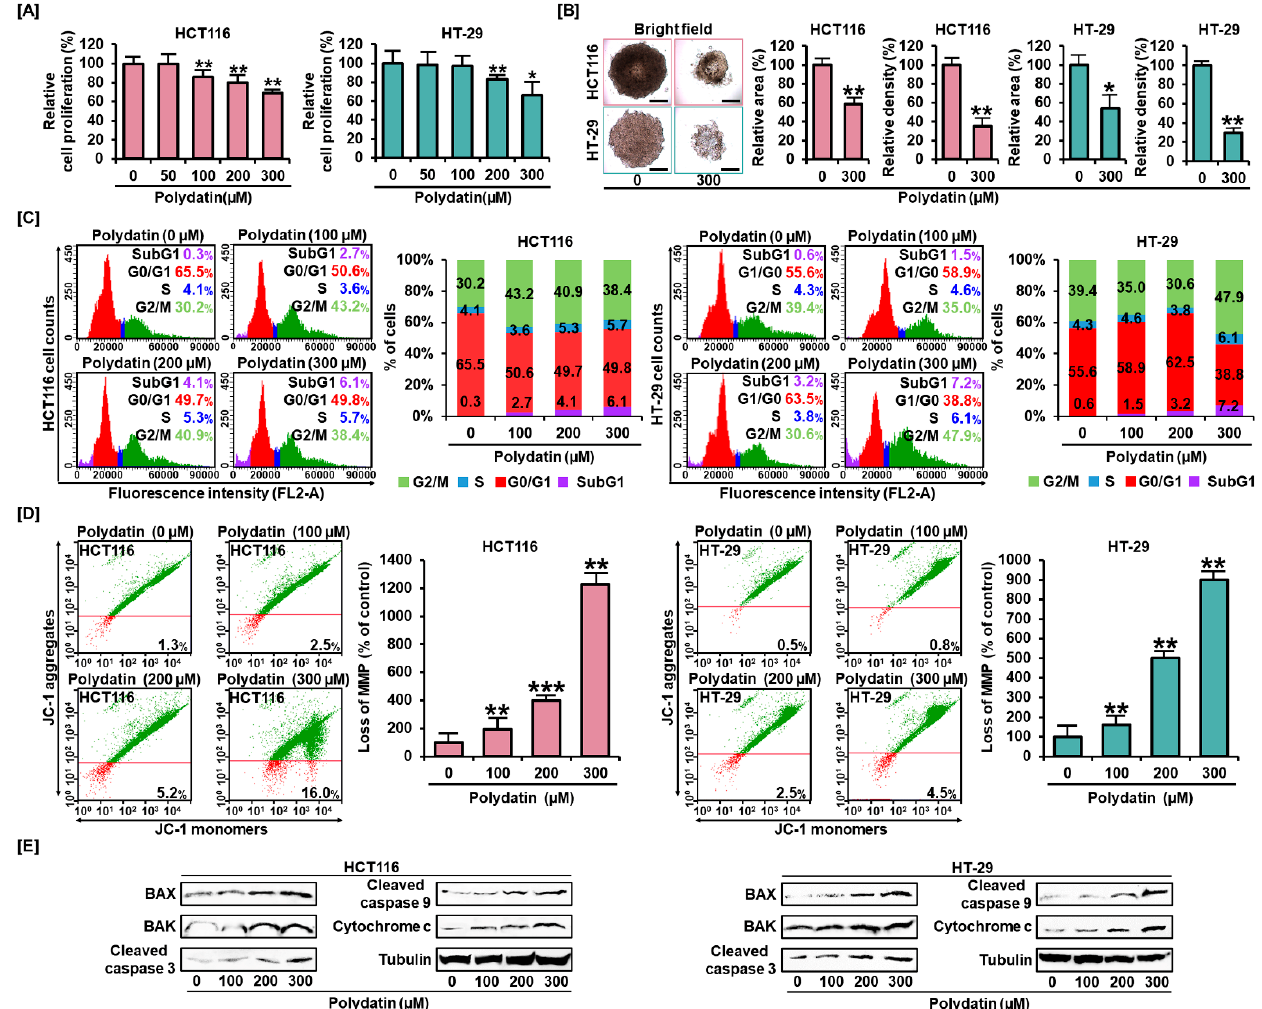
Figure 1. Anticancer effects of polydatin on colon cancer cells. ( A ) The proliferation analyses were conducted to determine the antiproliferative effects of polydatin (0, 50, 100, 200, and 300 μ M). The relative proliferative degree of HCT116 and HT-29 cells gradually decreased with increased polydatin concentration. ( B ) The formation of spheroids was observed by Leica’s DM3000 microscope. Bright field images show the changes in spheroids morphology after treatment with 300- μ M polydatin. The relative total area and density of spheroids were quantified using ImageJ. Scale bar: 100 μ m. ( C ) The cell distribution in cell cycle was analyzed using PI staining. ( D ) The reduction of MMP was identified by JC-1 assay. Red represents JC-1 monomers and the green, JC-1 aggregates. The bar graphs show that the reduction of MMP was elevated with polydatin dose increasing (0, 100, 200 and 300 μ M) in HCT116 and HT-29 cells. ( E ) Western blot of apoptosis-related proteins after both colon cancer cells were added with various doses of polydatin (0, 50, 100, 200, and 300 μ M). The asterisks indicate significance of statistics between control and polydatin-treated groups (* p < 0.05, ** p < 0.01, and *** p < 0.001).